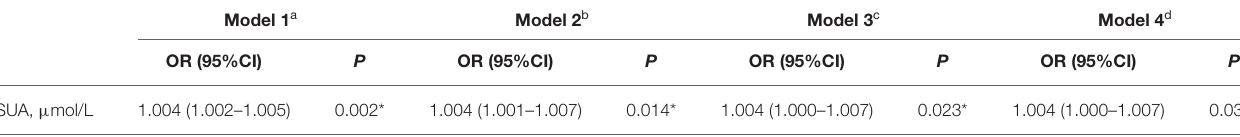
TABLE 2 | Logistic regression on analysis and sensitivity analysis in PNDRFAP study.